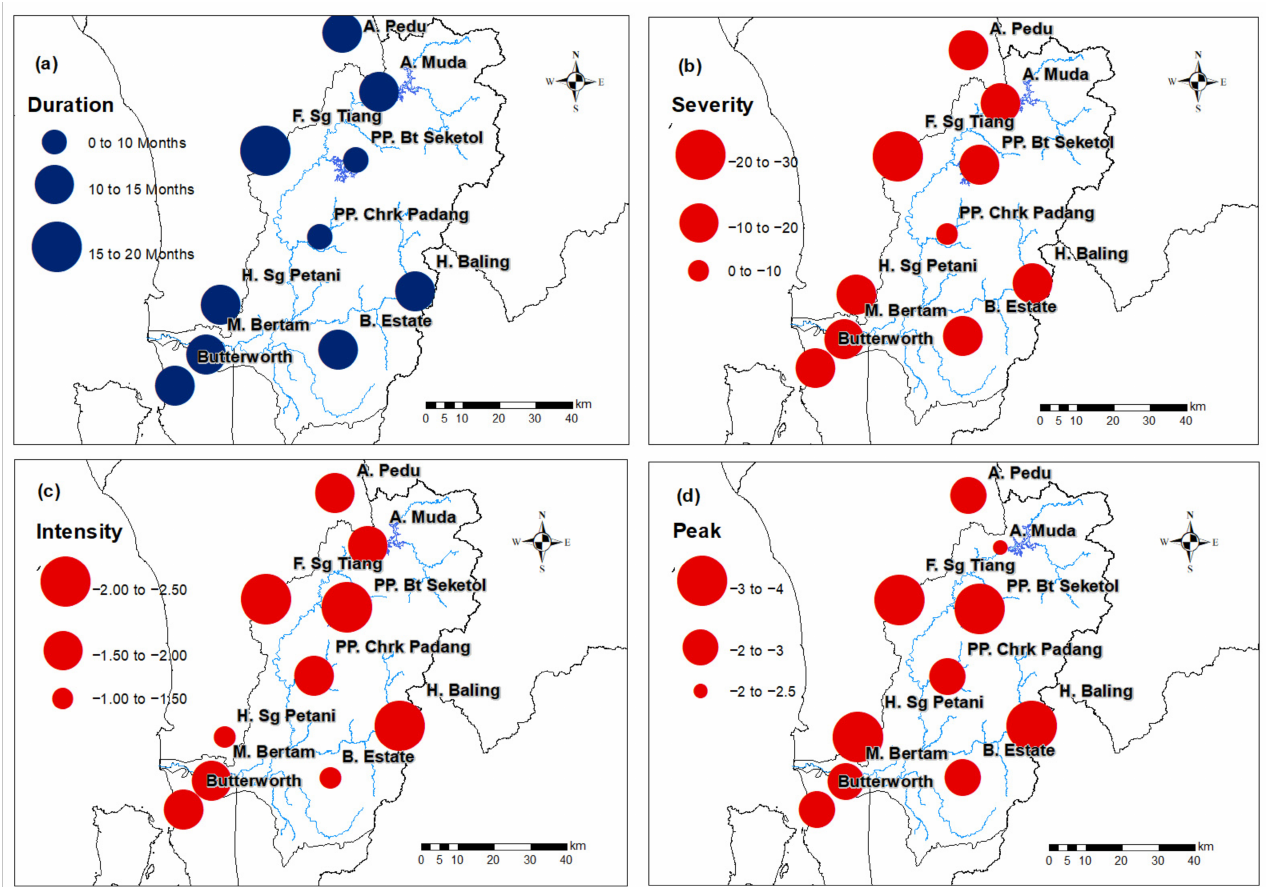
Figure 5. Characteristics of the ( a ) maximum drought duration, ( b ) maximum drought severity, ( c ) maximum drought intensity, and ( d ) maximum drought peak distributions in the MRB from 1985 to 2019. The highest maximum drought severity ( − 22.74) was detected at the Felda Sungai Tiang station, while the Pusat Pertanian Charok Padang station had the lowest